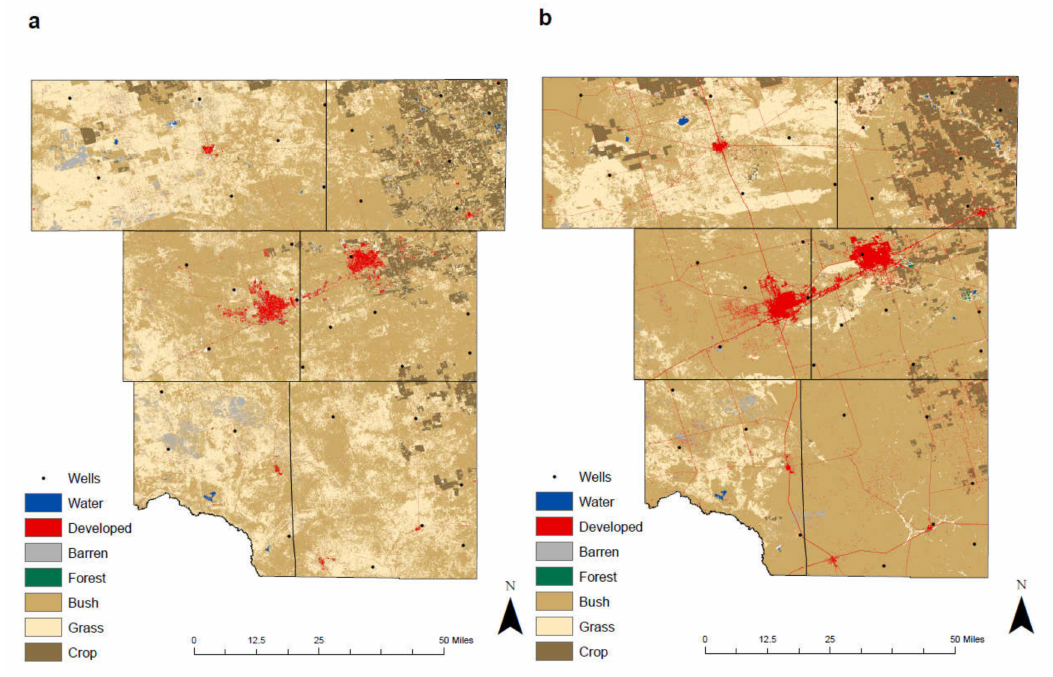
Figure 12. Land-cover maps of the study area; ( a ) NLCD 1992 and ( b ) NLCD 2011. NLCD: National Land Cover